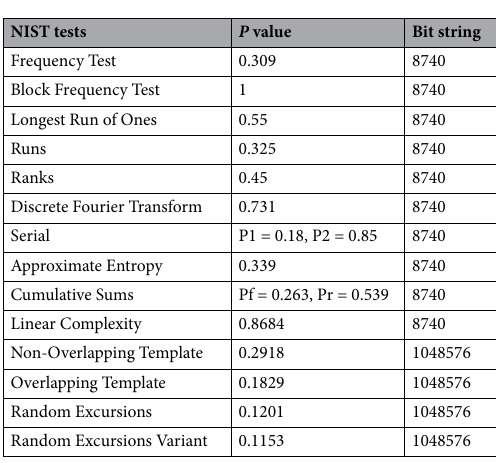
Table 4. NIST 15 tests’